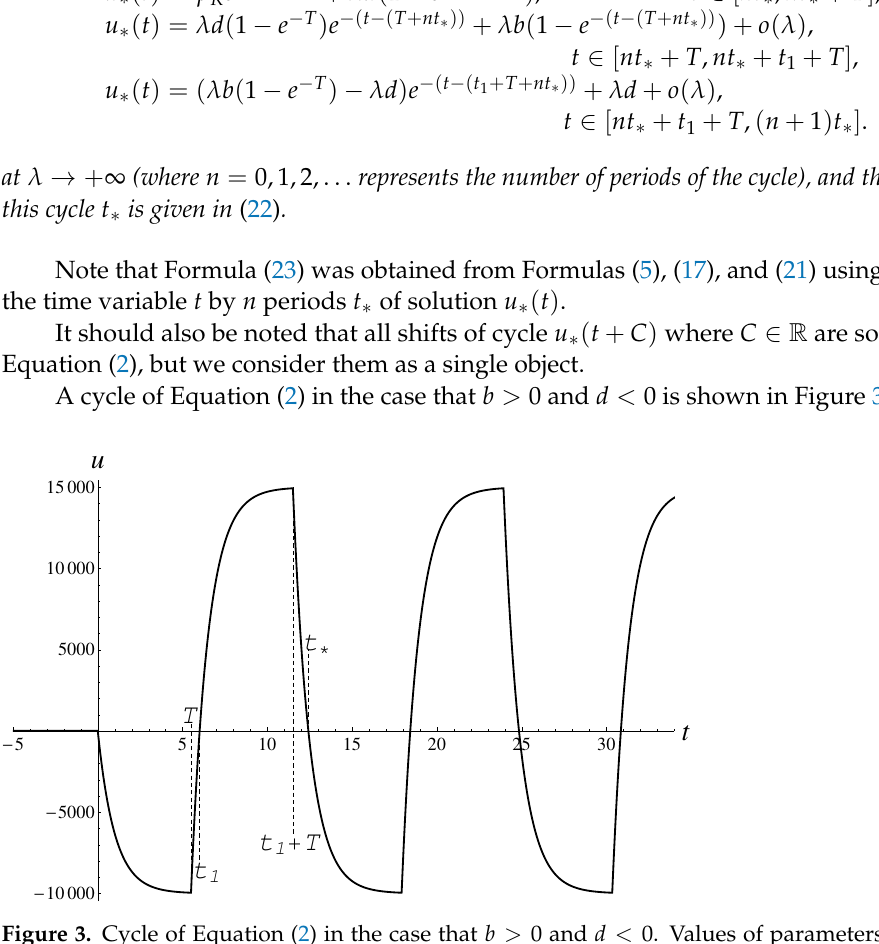
Figure 3. Cycle of Equation (2) in the case that b > 0 and d < 0. Values of parameters: λ = 10 4 , T = 5.5, p L = − 2, p R = 3, b = 1.5, and d = −